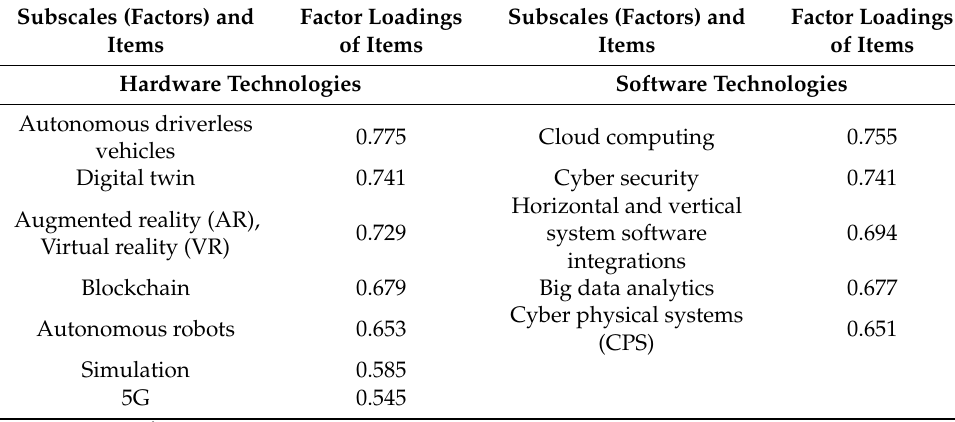
Table 9. Factor Loadings for EFA Model 1.